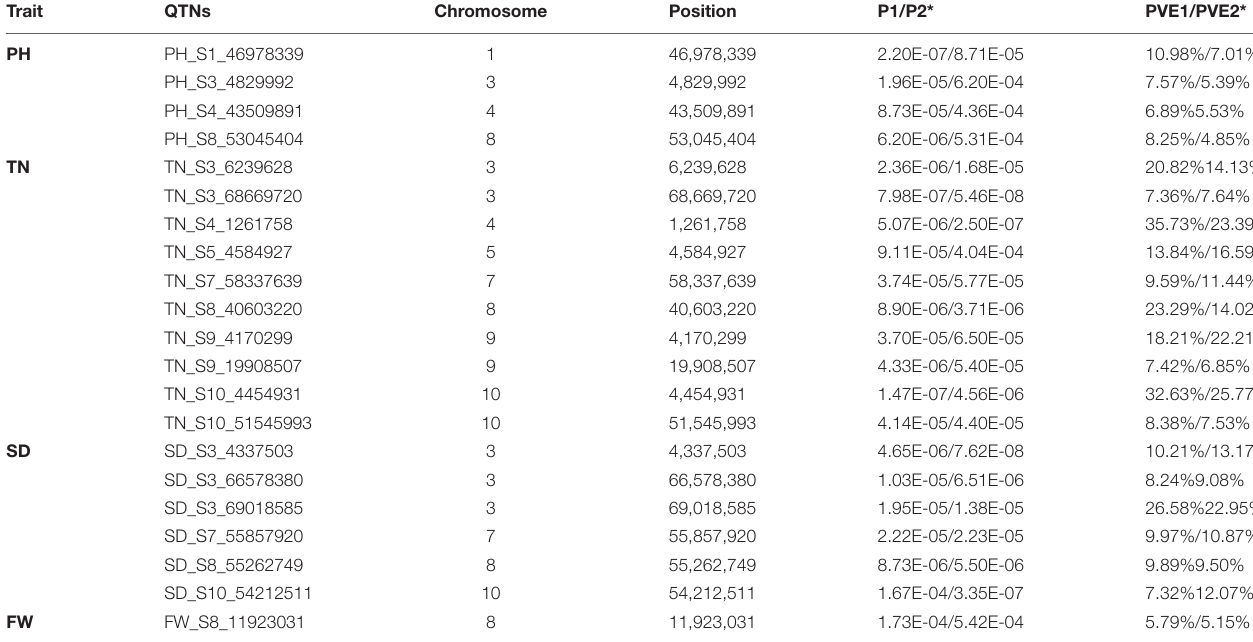
TABLE 2 | Quantitative trait nucleotides (QTNs) associated with four forage yield traits across two or more environments. Trait QTNs Chromosome Position P1/P2* PVE1/PVE2*